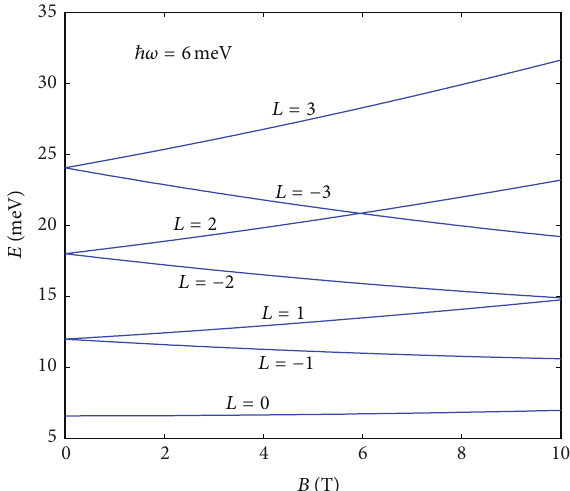
Figure 2: The energy spectrum of a single electron as a function of magnetic field for different quantum numbers of angular momen-